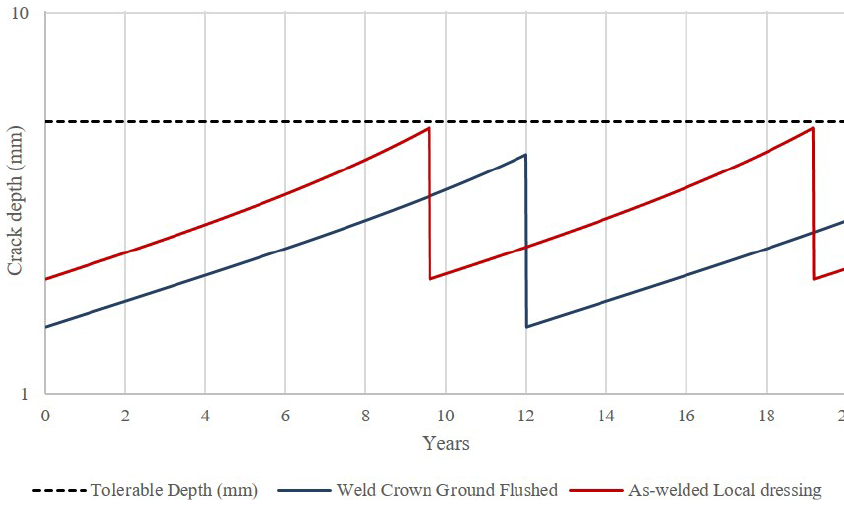
Figure 22. Effect of weld profile condition on in-service inspection.